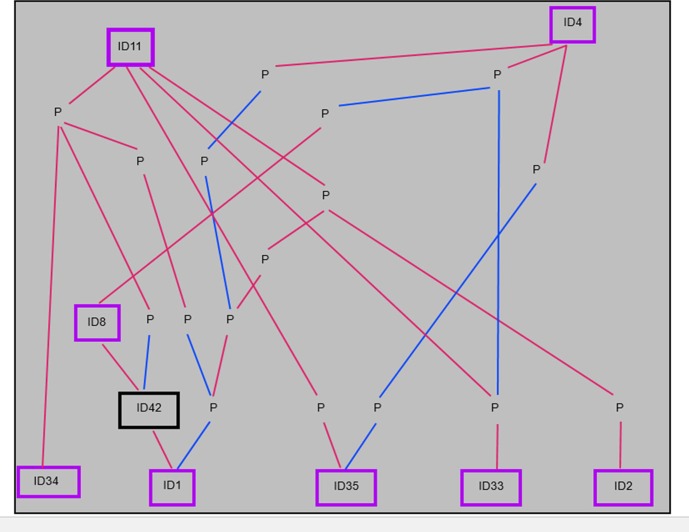
Diagram depicting the inter-relationships between eight of 11 ancestors significant to affected cohorts (outlined in purple) and one ancestor with affected offspring that is also a sire and broodmare sire of additional affected offspring (outlined in black), with ancestors in the pathways indicated by P. Sire lines are presented in pink, with dam lines in blue.